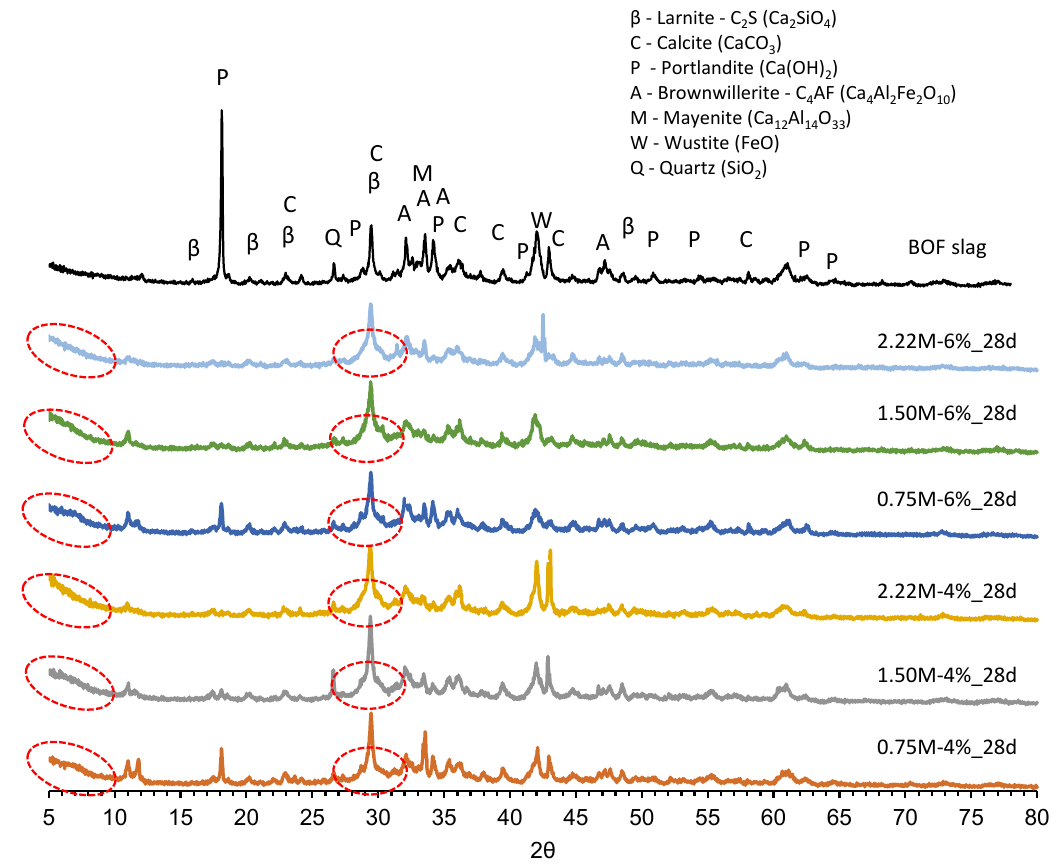
Figure 9. XRD patterns of pastes at 28 days (dotted red circle: broad hump indicating amorphous phase structure).